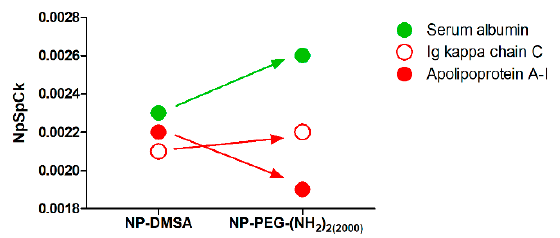
Figure 6. Relative abundance of opsonins (immunoglobulins and apolipoproteins) versus dysopsonins (albumin) on the protein corona composition of NP-DMSA and NP-PEG-(NH 2 ) 2(2000) .